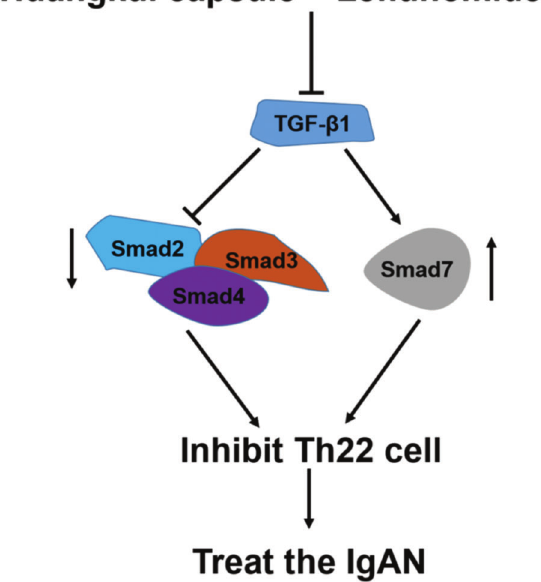
Figure 7 - Functional model of HKL for the treatment of IgAN. TGF- b 1, as a central regulatory factor, regulates the downstream expression of Smad2, Smad3, Smad4, and Smad7, thereby inhibiting the activity of Th22 cells. HKL: Huangkui capsule in combination with leflunomide, IgAN: Immunoglobulin A